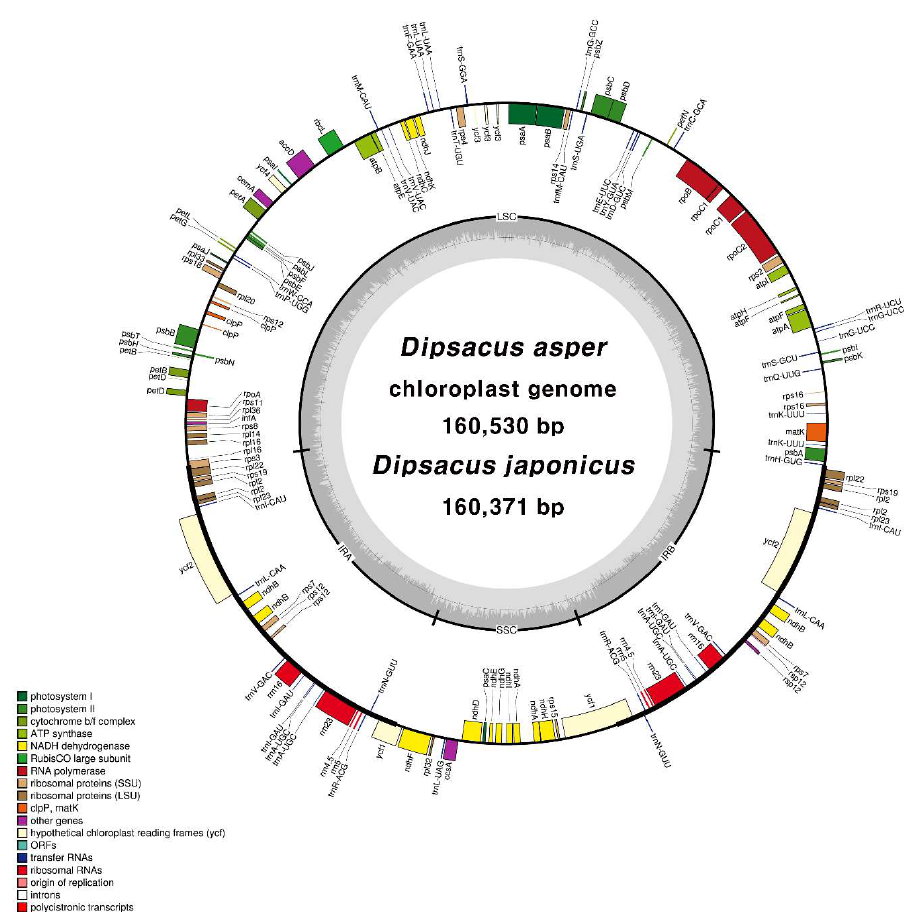
Figure 1. The circular gene map of Dipsacus asper and D. japonicus . The genes drawn inside the circle are transcribed clockwise, whereas those drawn outside the circle are transcribed counterclockwise. Dark gray shading inside the inner circle represents the GC content. LSC: large single copy; IR: inverted repeat; SSC: small single copy; GC: guanine-cytosine; ORF: open reading frame.